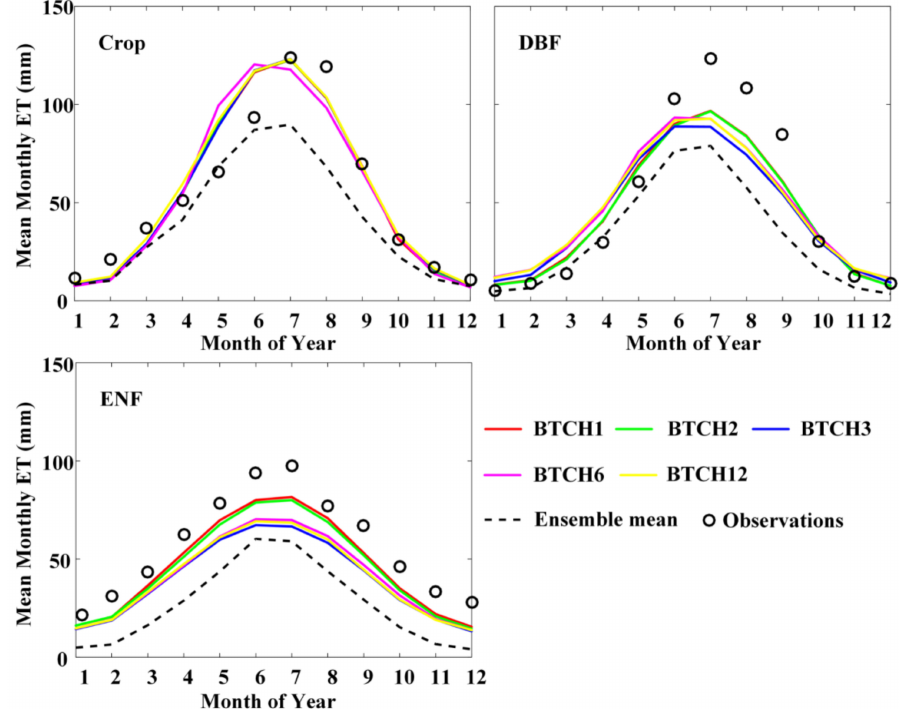
Figure 12. Monthly variations of evapotranspiration (ET) estimates from Bayesian-based three-cornered hat (BTCH) for di ff erent time windows, and ensemble mean (EM). BTCH1, BTCH2, BTCH3, BTCH6, and BTCH12 denote 1-month, 2-month, 3-month, 6-month, and 12-month time windows, respectively. The black circles are observations from eddy covariance flux